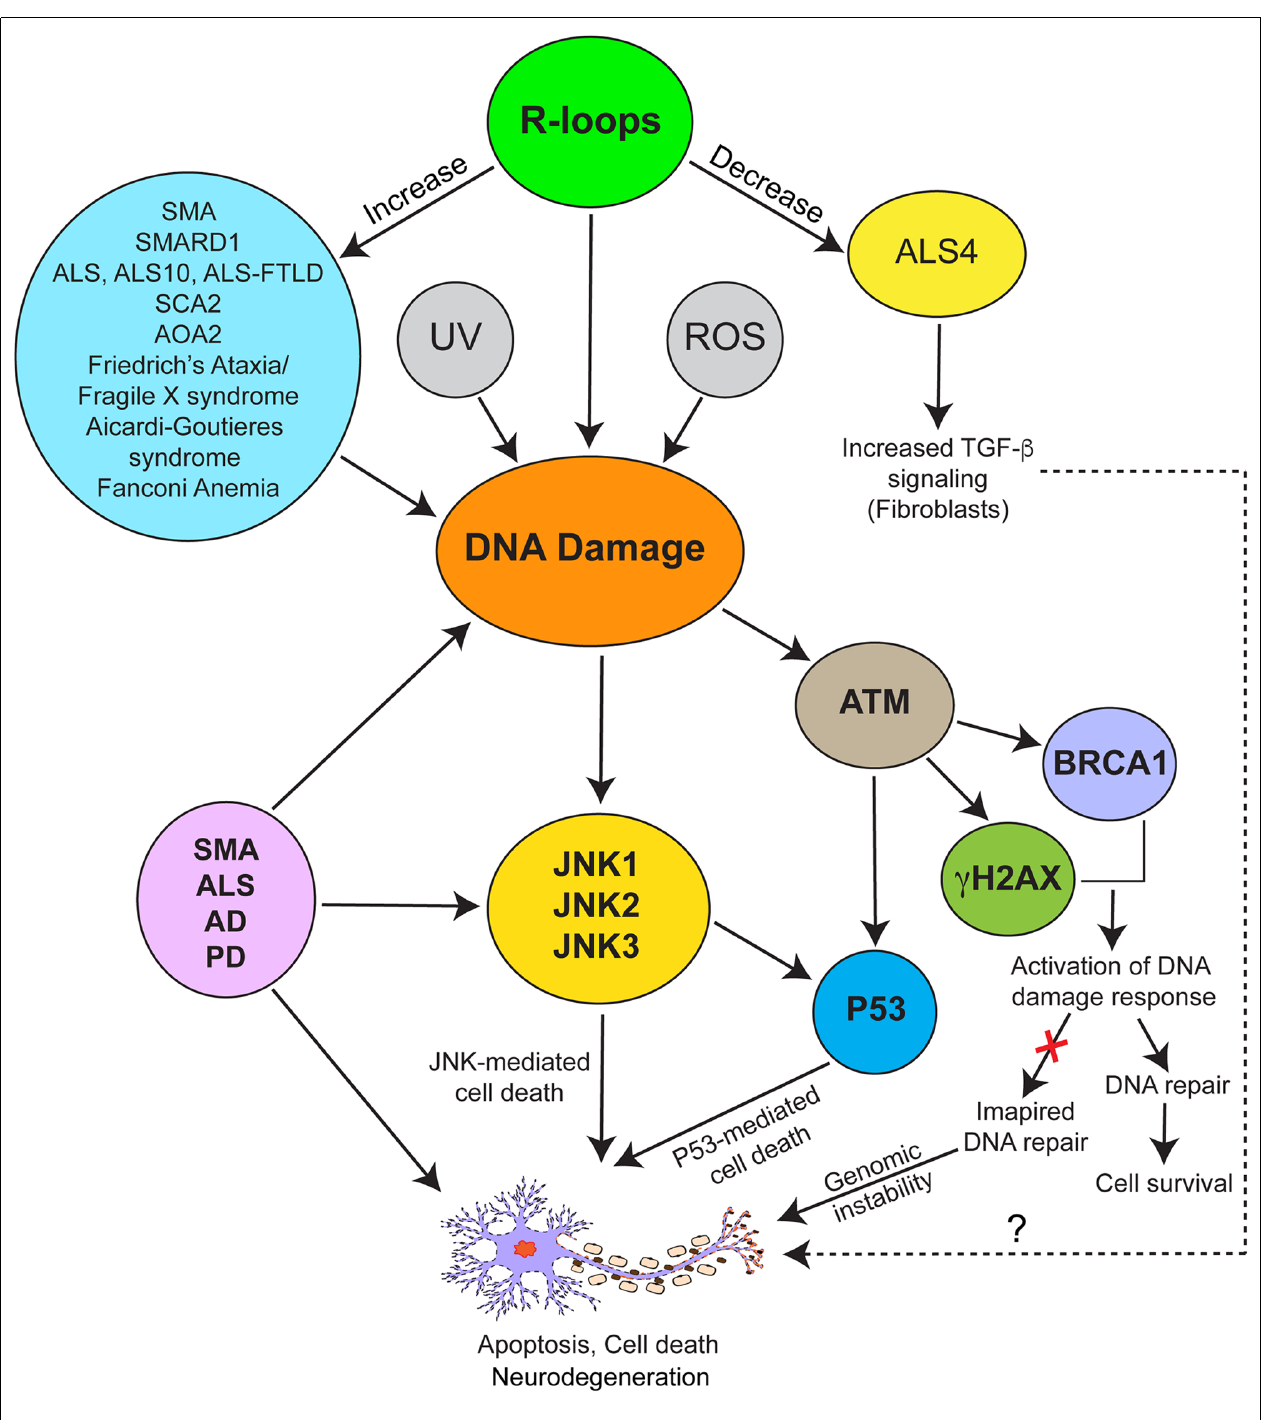
FIGURE 3 | Schematic representation of biochemical signaling mechanisms involved in mediating pathogenic effects of R-loop-mediated DNA damage in neurodegeneration associated with neurological disorders. SMA and various disorders (blue ellipse) are associated with increased R-loops (green ellipse) and DNA damage. R-loop accumulation, UV irradiation, and presence of reactive oxygen species (ROS) are among other causes of DNA damage. ALS4 (yellow ellipse) represents a special example of neuromuscular disorder caused by decrease in levels of R-loops, which is in contrast to SMA caused by increase in R-loop levels compared to controls. DNA damage response is mediated by activation of the JNK, ATM, and P53-mediated signaling pathways. ATM mediates phosphorylation of H2AX ( γ H2AX) and BRCA1 leading to activation of DNA damage and repair response. Both ATM and JNK phosphorylate P53, which may independently or synergistically contribute to P53-mediated cell death in response to DNA damage. Activation of the JNK pathway contributing to neurodegeneration has been reported in SMA, various forms of ALS, AD, and PD.